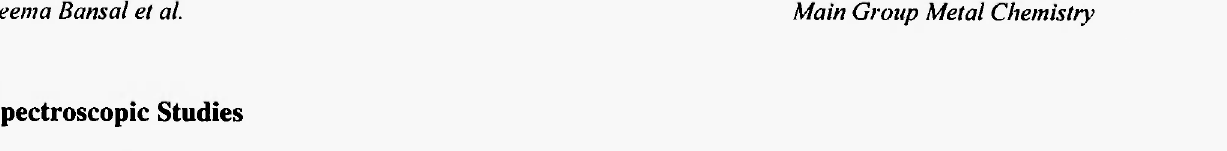
Selected IR bands (4000-200 cm"') for the new complexes